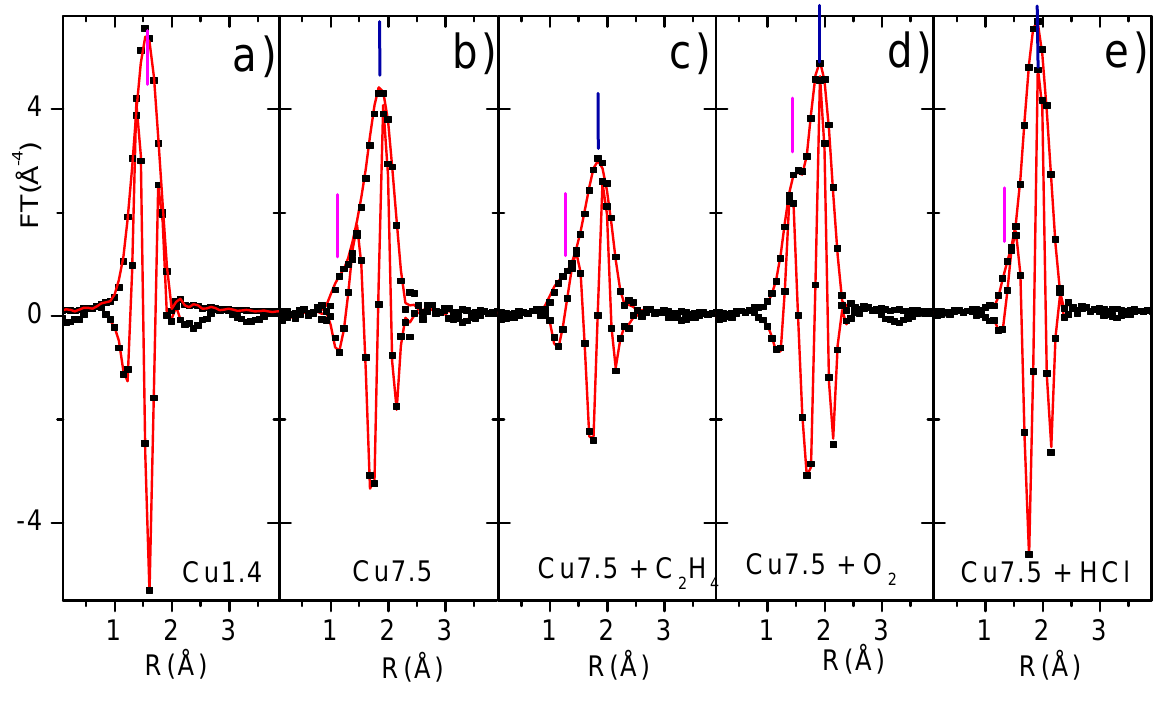
Figure 8. Modulus and imaginary parts of the phase-uncorrected, k 3 -weighted, FT of first shell EXAFS data: experimental (dotted black) best fits (full lines). Part a: sample Cu1.4 (only aluminate phase) . Part b activated Cu7.5 catalyst. Parts c,d,e): sample Cu7.5 the along the catalytic